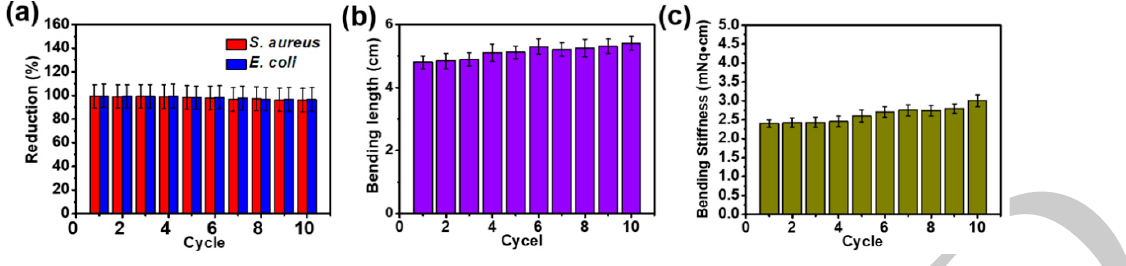
Figure 7. ( a ) Antibacterial activity of cotton-3 fabrics against E. coli and S. aureus during five antibacterial cycles. Bending length ( b ) and bending stiffness ( c ) in the softness test of cotton-3 fabrics.